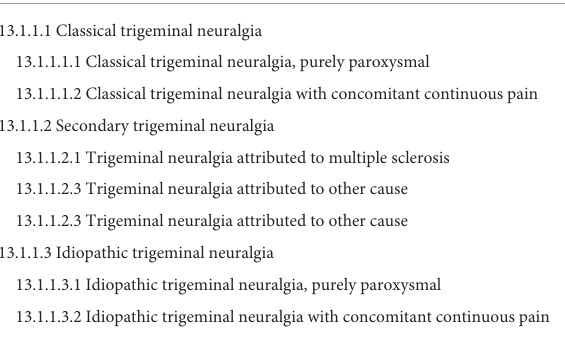
TABLE 1 The international classification of headache disorders, 3rd